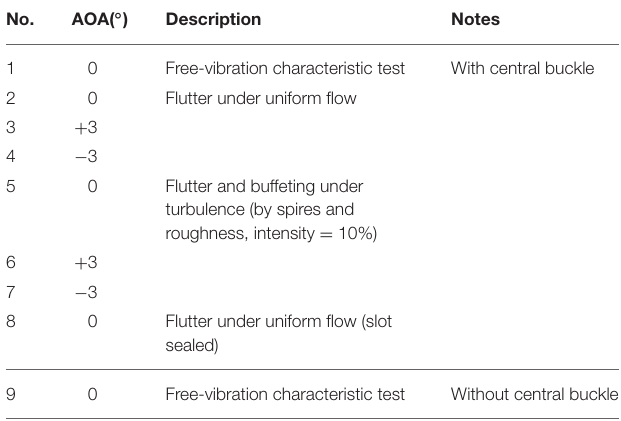
TABLE 3 | Case list for wind tunnel test.